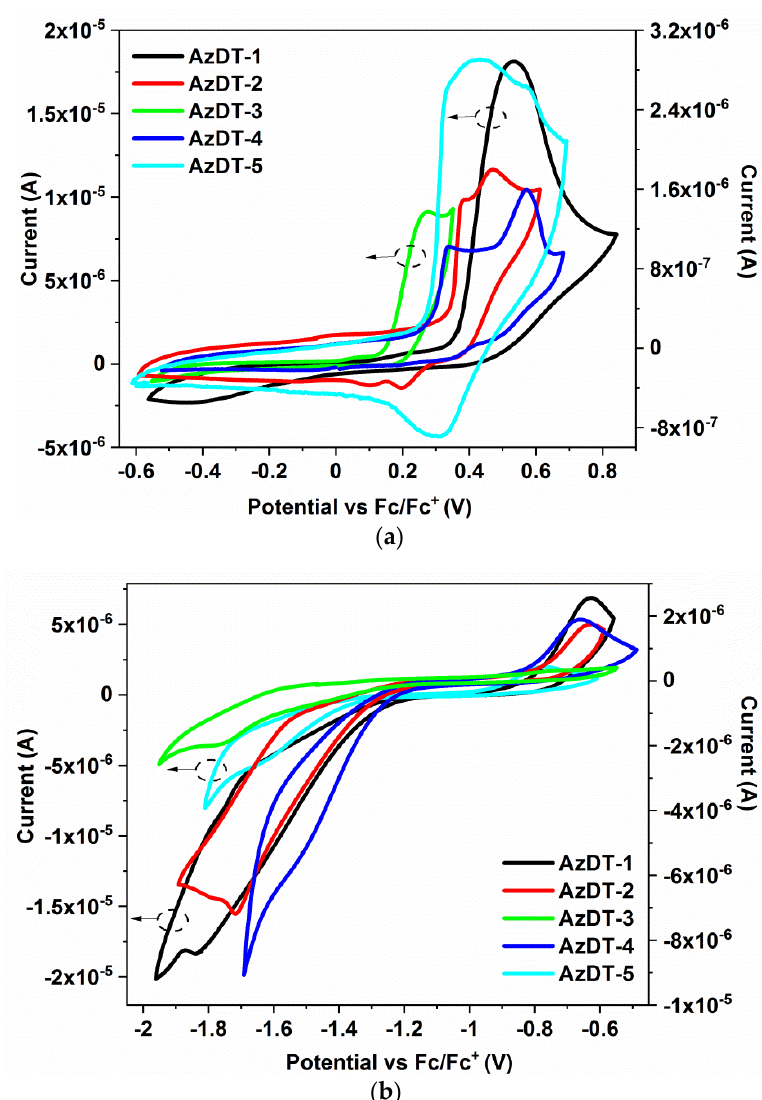
Figure 2. The voltammograms of the ( a ) oxidation and ( b ) first reduction processes (Pt, v = 0.1 V/s, 0.1 mol/dm 3 Bu 4 NPF 6 in CH 2 Cl 2 with 10 − 3 mol/dm 3 concentration of AzDT).